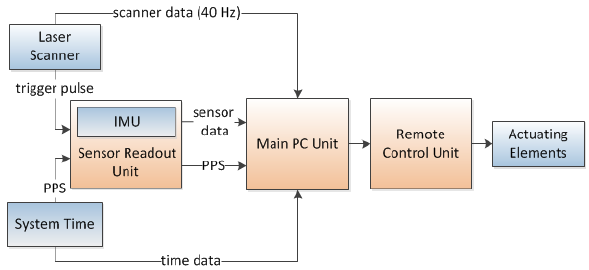
Figure 2: Simplified structure of UGV and UAV components supplemented and replaced for the most part. Among others with two specifically developed boards, a Sensor Readout Unit and a Remote Control Unit.